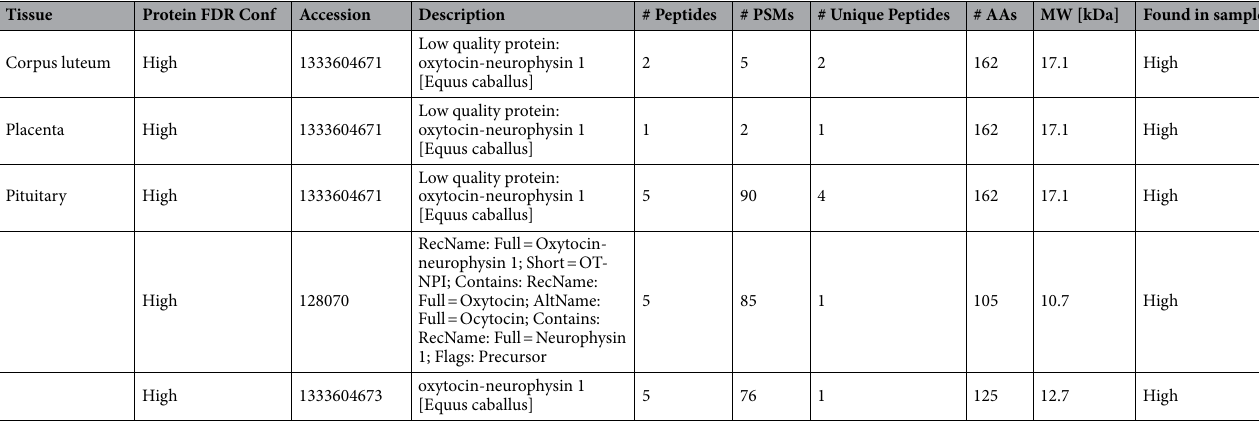
Table 2. Identification of neurophysin-oxytocin (OXT) by the liquid chromatography-tandem mass spectrometry (LC–MS/MS) from the 10-15 kDa bands of various tissues from the Coomassie blue gel. Protein false discovery rate confidence (Protein FDR Conf) = High means FDR < 0.01; number (#) of peptides = the number of distinct peptide sequences in the protein group; Number of peptide spectrum matches (#PSMs) = the total number of identified peptide sequences for the protein; # Unique peptide = number of the peptide sequences unique to a protein group; Number of amino acids (#AA) = the sequence length of a protein; Molecular weight (MW[kDa]) = calculated molecular weight of the protein; Found in sample = high, peak found, or peak not